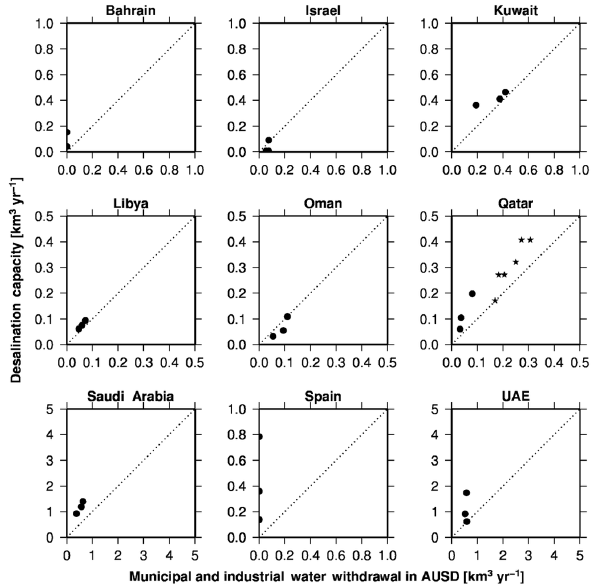
Figure 5. Comparison between national desalination capacity and municipal and industrial water withdrawal in AUSD cells. Each plot indicates one specific year. The shape of symbols indicate the data source of municipal and industrial water withdrawal in AUSD cells: circles for AQUASTAT and stars for MDPS